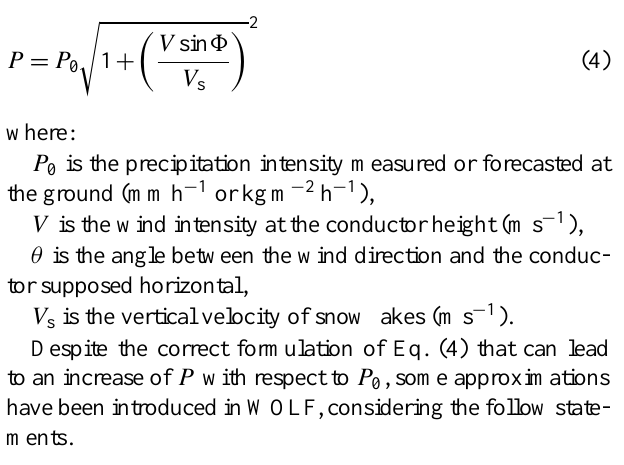
Italian power grid. The empirical coefficient γ has been